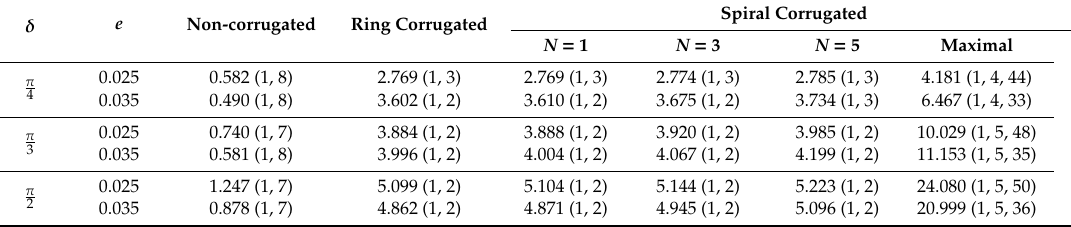
Table 5. The critical buckling pressure of corrugated sandwich FGM cylindrical shells with di ff erent values of geometrical parameters of trapezoidal corrugation (MPa) ( K 1 = 10 7 N / m 3